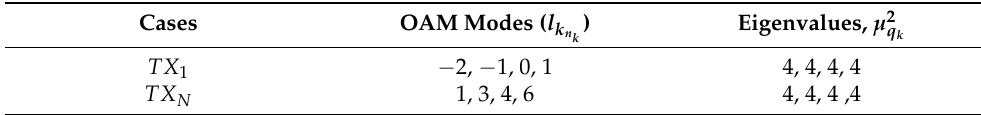
Table 2. Number of Tx and respective OAM modes via mode combination for the OAM-MIMO-RASK